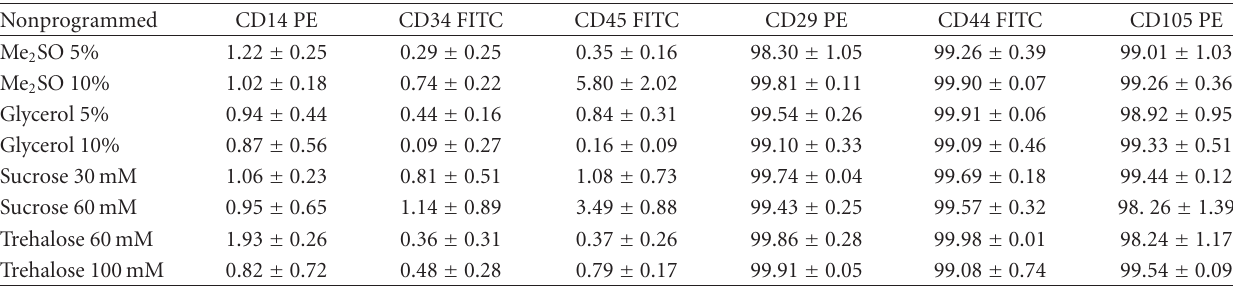
Figure 4: AFSCs plasticity. AFSCs were seeded in 6-well plates and cultivated with osteogenic, adipogenic, and chondrogenic inductor medium for 3 weeks. (a) Control cells cultivated without inductor medium (magnification: 40x). (b) Osteogenic di ff erentiation was assessed by von Kossa (calcium deposits in black) and (c) Alizarin Red (calcium deposits in red) staining. Adipogenic di ff erentiation was assessed by Oil Red O staining. (d) Di ff erentiated cells without staining (magnification: 40x), (e) di ff erentiated cells stained by Oil Red O (cytoplasmic lipids droplets in red, 400x). (f) Chondrogenic di ff erentiation was confirmed with H&E (magnification: 400x) (g) and immunofluorescence staining with antibodies against collagen type II (400x). (h) Osteogenic gene expression was determined by RT-PCR; products were electrophorezed and visualized under ultraviolet light in 2% agarose gel stained with ethidium bromide (100bp molecular weight, control (water), osteopontin [OPN], osteocalcin [OCN] and Wnt-1). (i) Typical adipogenic gene expression was determined by RT-PCR (100 bp molecular weight, control (water), PPAr- γ and lipoprotein lipase). (j) Chondrogenic gene expression was determined by RT-PCR (100 bp molecular weight, control (water), collagen type II, perlecan, and syndecan). Table 2: After nonprogrammed freezing, AFSCs ( n = 5) maintained their specific mesenchymal membrane proteins evaluated by flow cytometry (CD29, CD44, and CD105 positive; CD14, CD34, and CD45 negative). The number of acquired events was 15,000 in each acqui- sition. Results are shown as percentage ±